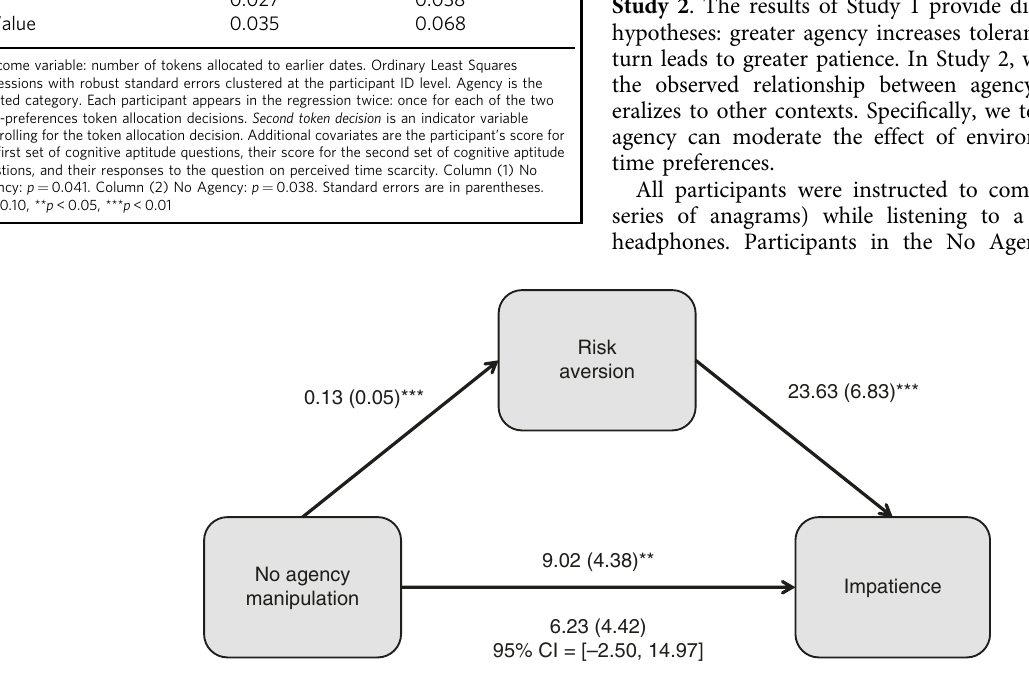
Fig. 3 Study 1: the effect of lack of agency on impatience, as mediated by risk aversion. All statistics compare only the two scarcity groups and use OLS with robust SE clustered at the participant ID level. Regression coef fi cients are unstandardized. Standard errors are in parentheses. For the pathway from No Agency manipulation to Risk Aversion : p = 0.006; for the pathway from Risk Aversion to Impatience: p = 0.001. For the pathway from No Agency manipulation to Impatience , the values above the arrow stem from the model without the mediator ( p = 0.041), whereas the values below the arrow stem from the model with the mediator ( p = 0.160). * p < 0.10, ** p < 0.05, *** p <